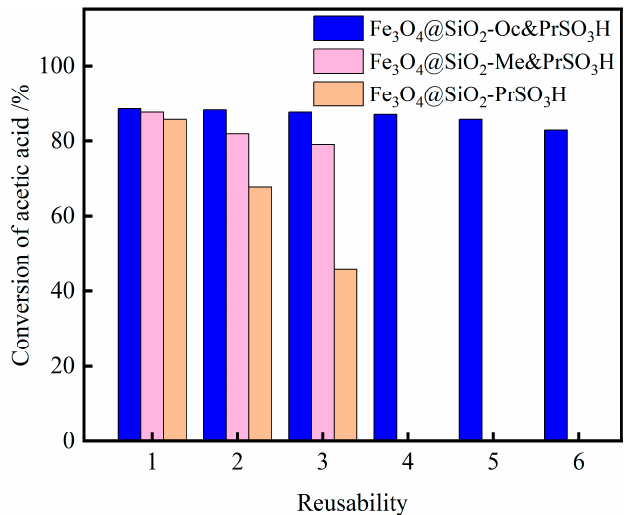
Figure 13. Reusability of catalysts Fe 3 O 4 @SiO 2 -PrSO 3 H, Fe 3 O 4 @SiO 2 -Me&PrSO 3 H, and Fe 3 O 4 @SiO 2 - Oc&PrSO 3 H (reaction conditions: n EtOH :n HOAc = 6:1, 1 wt% catalyst loading, 80 °C, 3 h, 640 rpm).